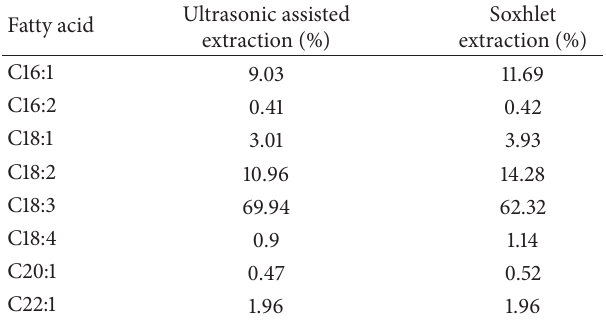
Table 3: Fatty acid compositions (% of total fatty acids) of tara seed oils extracted by different